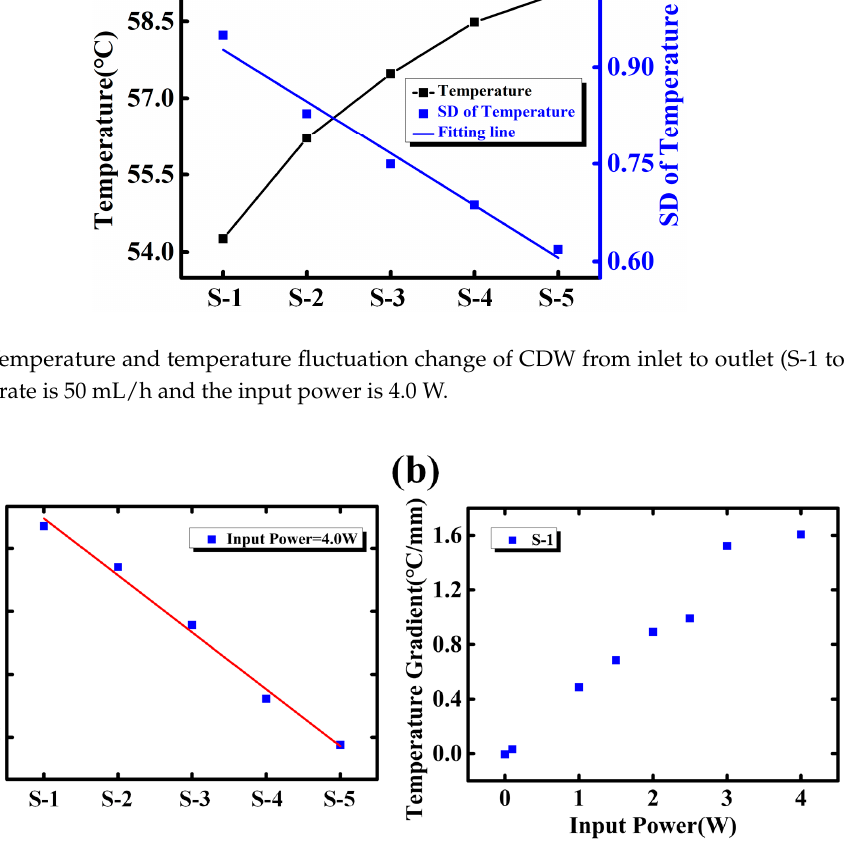
Figure 10. ( a ) Temperature gradient changes along the microchannel (S-1 to S-5); and ( b ) temperature gradient changes with different input power.